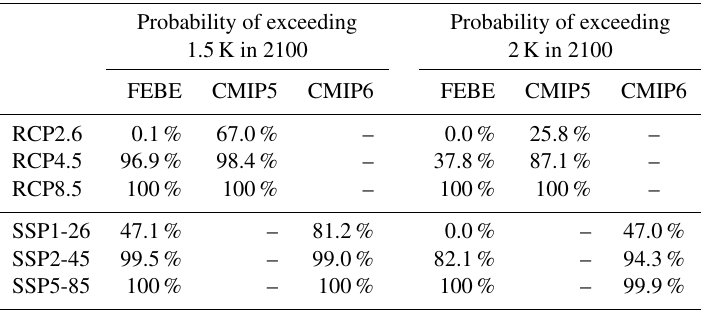
Figure 13. The probability for the global mean surface temperature of exceeding a 1.5K threshold (a, c) and a 2K (b, c) are given as a (a, b) or F Aer (c, d) and for the CMIP5/6 MME (grey). The three scenarios are function of years for the FEBE (blue), using F Aer RCP SSP considered for each case: RCP2.6/SSP1-26 (solid), RCP4.5/SSP2-45 (dashed) and RCP8.5/SSP5-85 (circles). Table 6. List of RCP and SSP scenarios analysed in this study and the probabilities of exceeding 1.5 or 2K based on the FEBE and the CMIP5/6 MME. Summary of Fig.